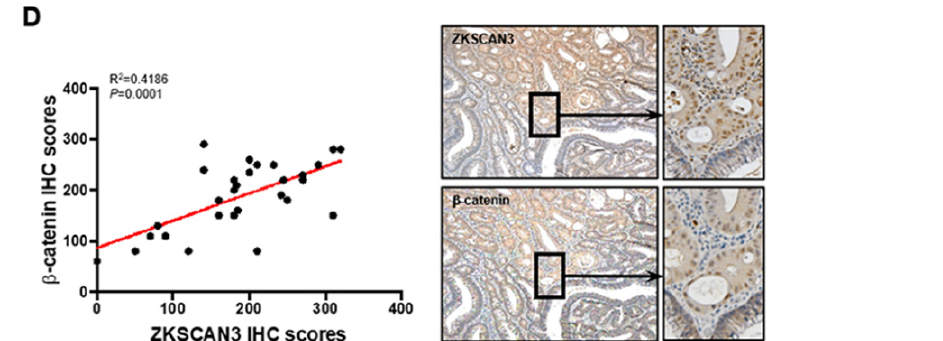
Figure 7. ZKSCAN3 upregulation in the early stage of the adenoma–carcinoma sequence. ( A ) Distribution of IHC scores in the normal colonic epithelium (NM; n = 38), non-neoplastic hyperplastic polyps (HPP; n = 31), adenomas (AD; n = 34), adenocarcinomas (AC; n = 30), and their representative microscopic images (right panel). Optical magnification, ×100. Red bars represent the median with quartiles of the IHC scores. Statistical significance was determined using one-way ANOVA followed by Duncan’s test (* p < 0.01). ( B ) Representative ZKSCAN3 IHC images of adenoma with dysplasia. Optical magnification, ×200 (left panel) and ×400 (right panel). ( C ) Gene copy numbers of normal epithelium ( n = 14), non-neoplastic hyperplastic polyps ( n = 16), dysplastic adenomas ( n = 14), and adenocarcinomas ( n = 22). ( D ) Correlation between IHC scores of ZKSCAN3 and β -catenin. Data were obtained from 29 cases of adenomas and analyzed through Pearson correlation ( p < 0.01). Representative IHC images are shown in the right panel. Optical magnification, 100 (middle panel) and ×200 (right panel). ns, not significant.